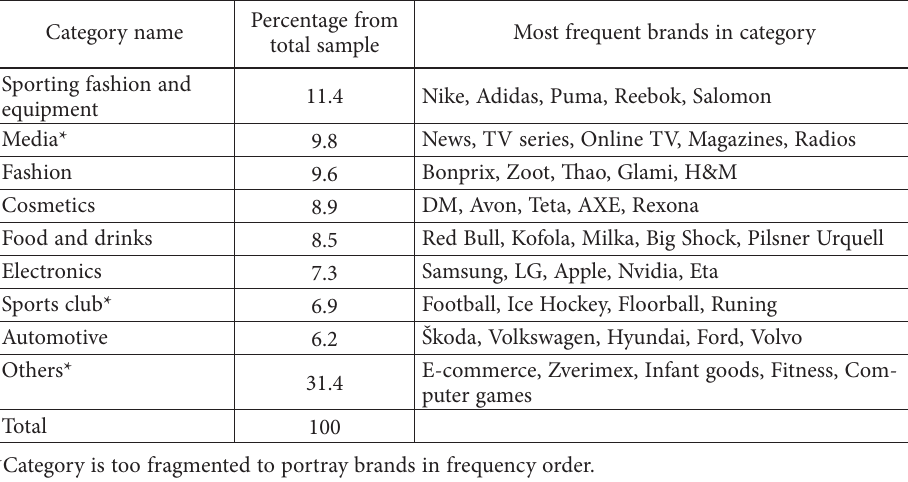
Table 2. Brands followed on Facebook (source: own research)